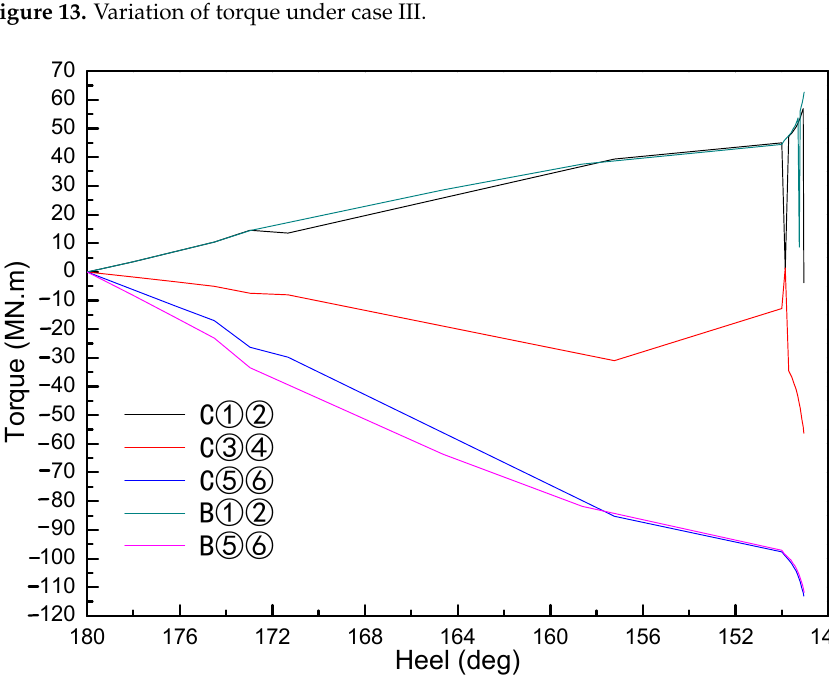
Figure 14. Variation of torque under case Ⅳ .